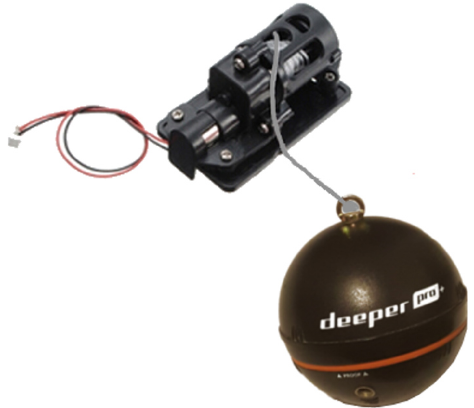
Figure 2. Deeper sonar is connected to a UAV with a wire winch.